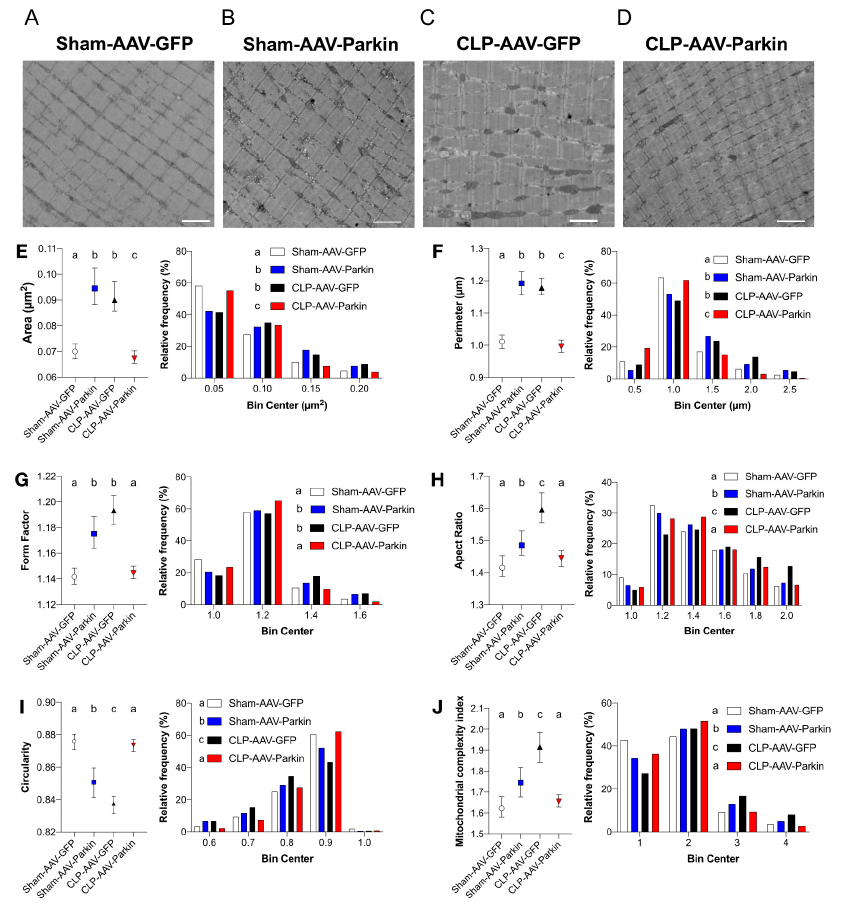
Figure 5. The impact of sepsis and Parkin overexpression on mitochondrial morphology in skeletal muscle. ( A – D ) Representative longitudinal TEM images from all groups that were used to assess mitochondrial morphology. Scale bar: 2µm. ( E – J ) Median values with 95% confidence interval (left) and relative frequencies (right) of multiple mitochondrial shape descriptors (Sham-AAV-GFP: n = 1246; Sham-AAV-Parkin: n = 728; CLP-AAV-GFP: n = 1149; CLP-AAV-Parkin: n = 1206). Groups not sharing a letter are significantly different (differences were tested using a Kruskal–Wallis test followed by a Dunn’s multiple comparisons test; p < 0.05).